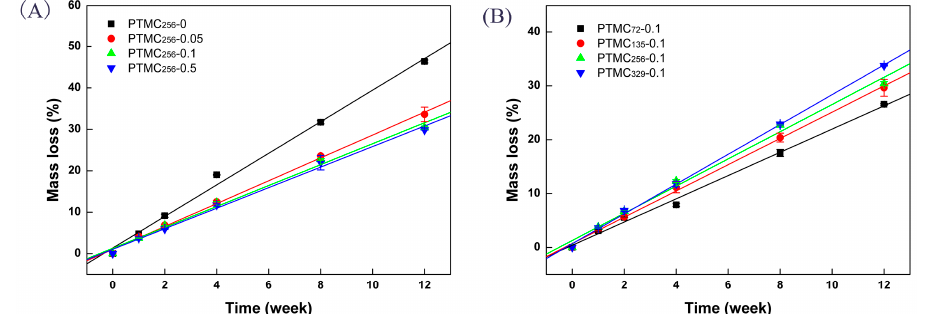
Figure 1. The mass loss of bis(trimethylene carbonate) (BTB) cross-linked PTMC-Ns with: different cross-linker amount ( A ); and different initial molecular weight ( B ), during in vitro enzymatic degradation as a function of time.